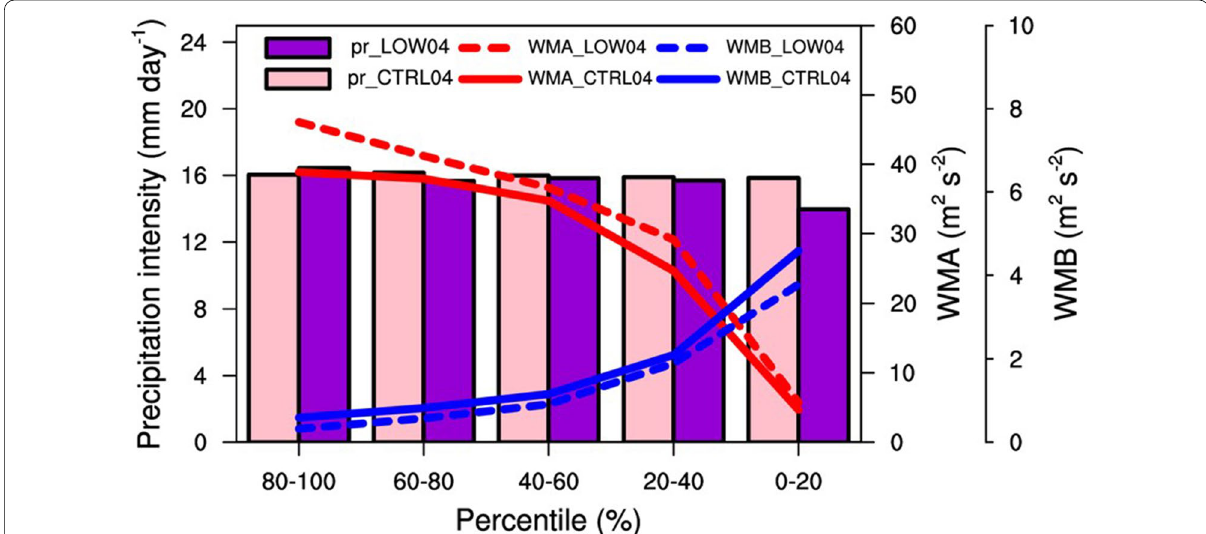
Fig. 9 Precipitation intensities (bar graph, mm different quantiles of topographic height (%)